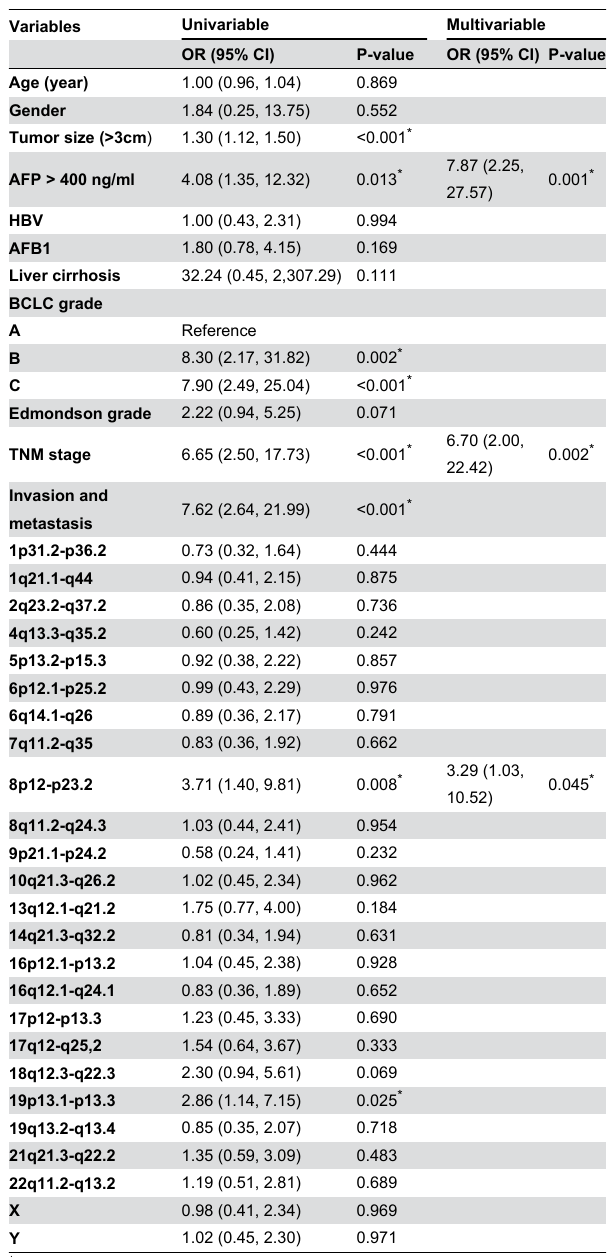
Table 3. Univariate and multivariate analysis of patient characteristics and RARs with tumor-free survival using COX regression